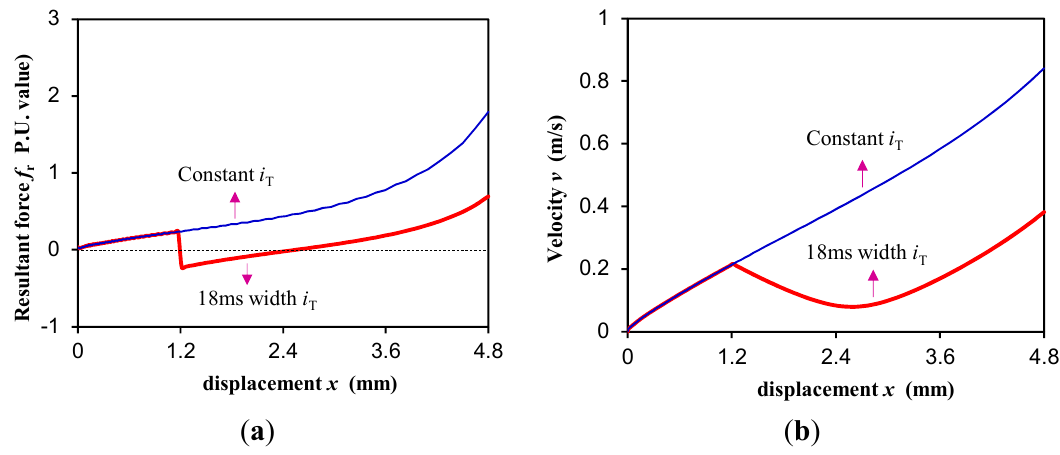
Figure 10. Dynamics characteristic under different pulse width. ( a ) Resultant horizontal force; ( b )